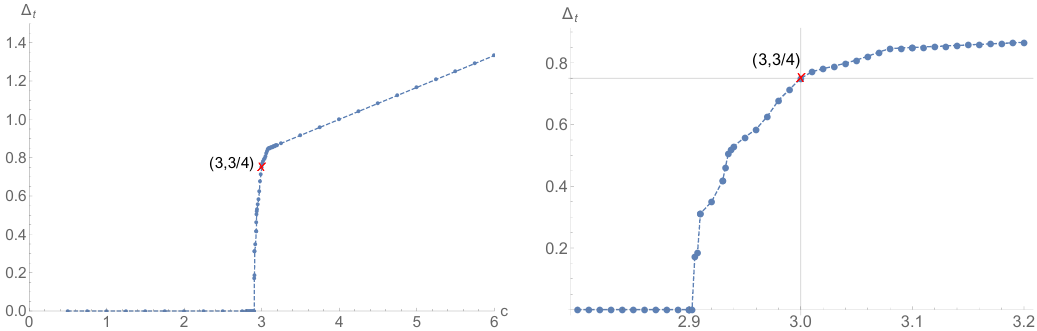
Figure 20. Numerical bound on twist gap with W (2 ; 3 ; 4) algebra. It turns out that the ( b A 3 ) 1 WZW model is realized on the numerical